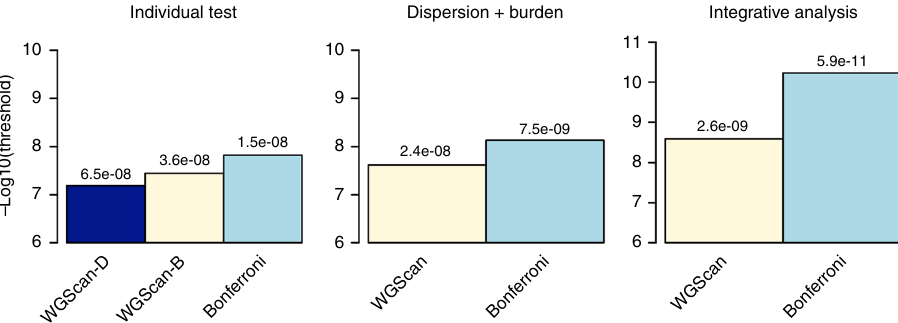
Fig. 4 Estimated signi fi cance thresholds for whole-genome sequencing studies (based on the Simons Simplex Collection data). Bars present estimated genome-wide signi fi cance thresholds ( − log10 scale) for different tests. WGScan: WGScan with dispersion and burden tests (two tests per window). WGScan-I: 127 tissue-speci fi c GenoNet scores are integrated, in addition to the original burden and dispersion tests (for a total of 256 tests per window). The signi fi cance threshold is estimated for the minimum p -value of all tests. The Bonferroni threshold is de fi ned as 0.05 divided by the total number of tests. Source data are provided as a Source Data fi